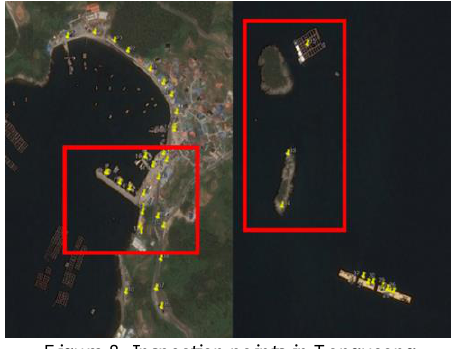
Figure 8. Inspection points in Tongyeong